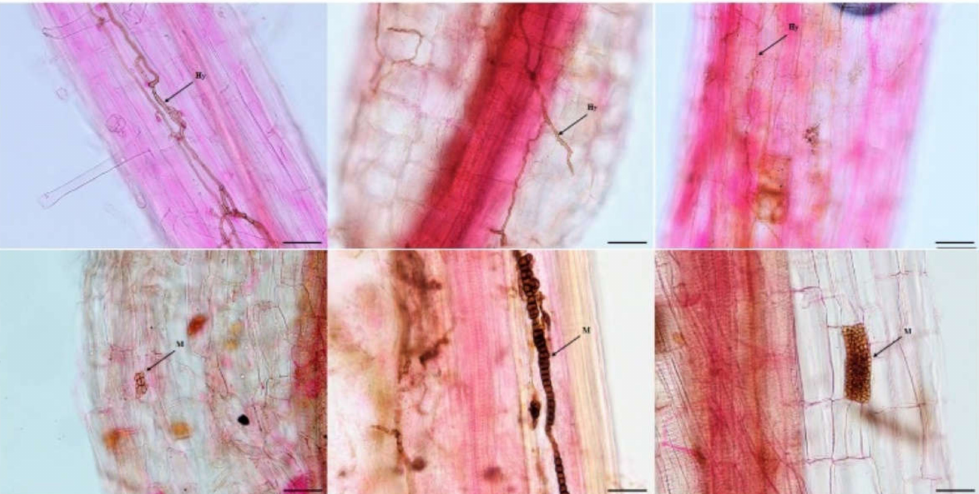
Figure 1. Dark septate endophytes associated with the roots of Artemisia ordosica growing in natural habitats. bars = 50 µ m. Arrows indicate the following: Hy, DSE hyphae; M, DSE microsclerotia.